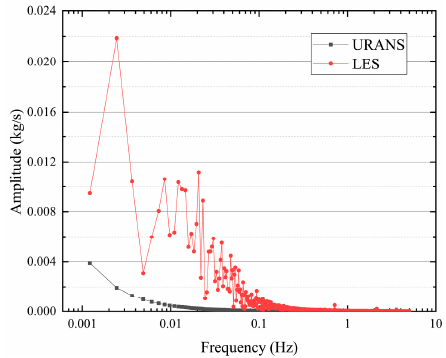
Figure 7. Comparison of mass flow rate amplitude spectrum.